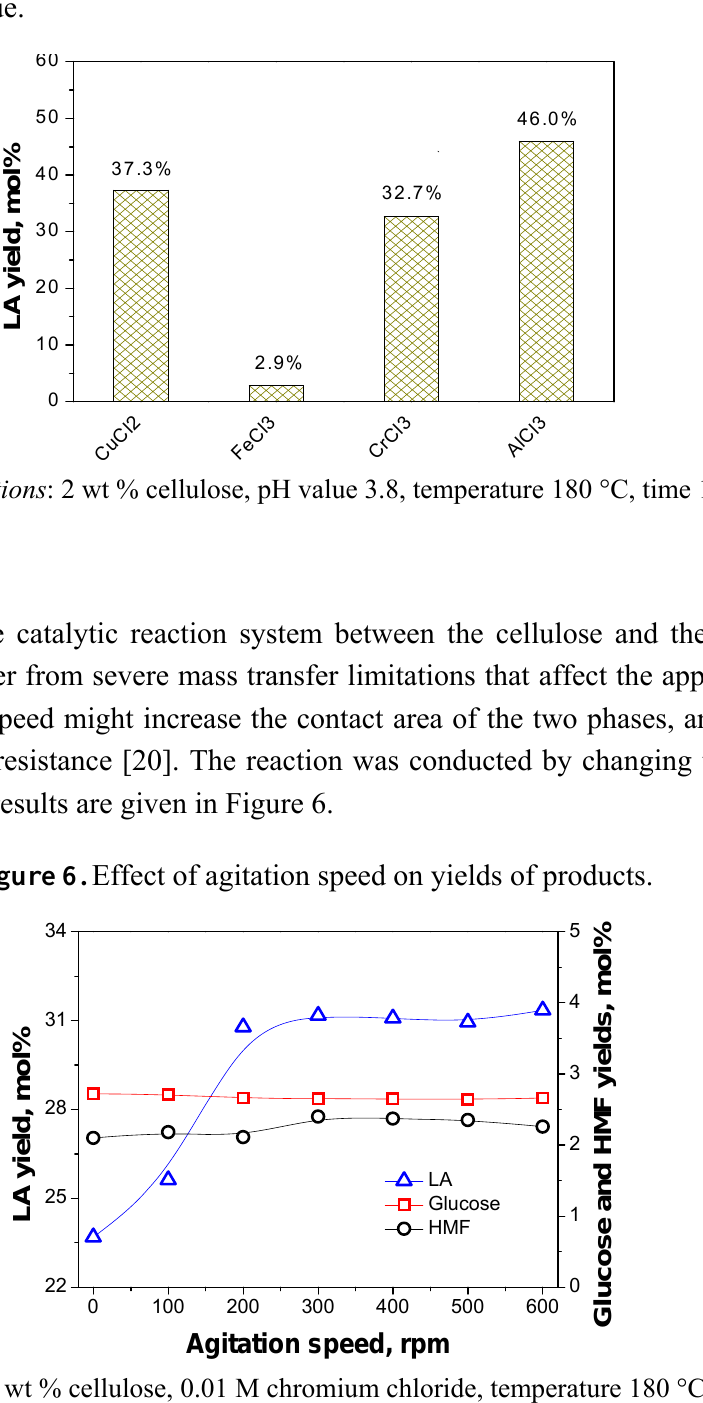
Figure 5. Effect of various types of metal chlorides on the hydrolysis of cellulose at the same initial pH value.